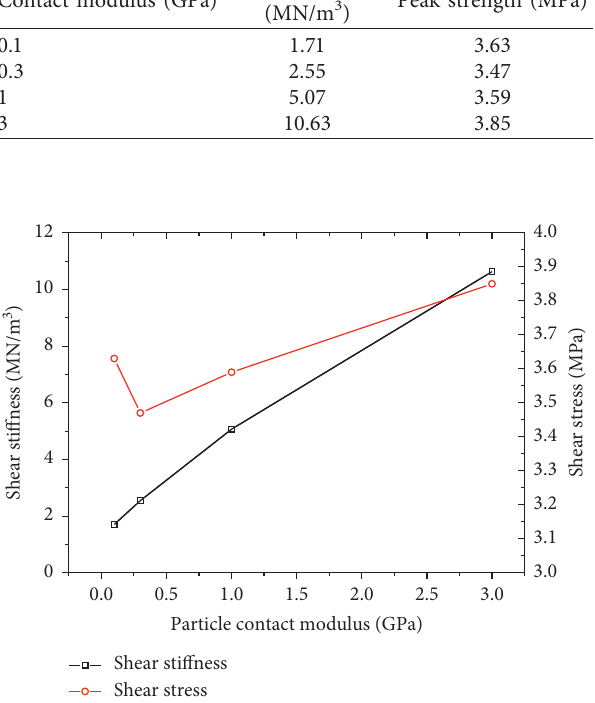
Figure 3: Point diagram of the relationship between contact modulus and shear